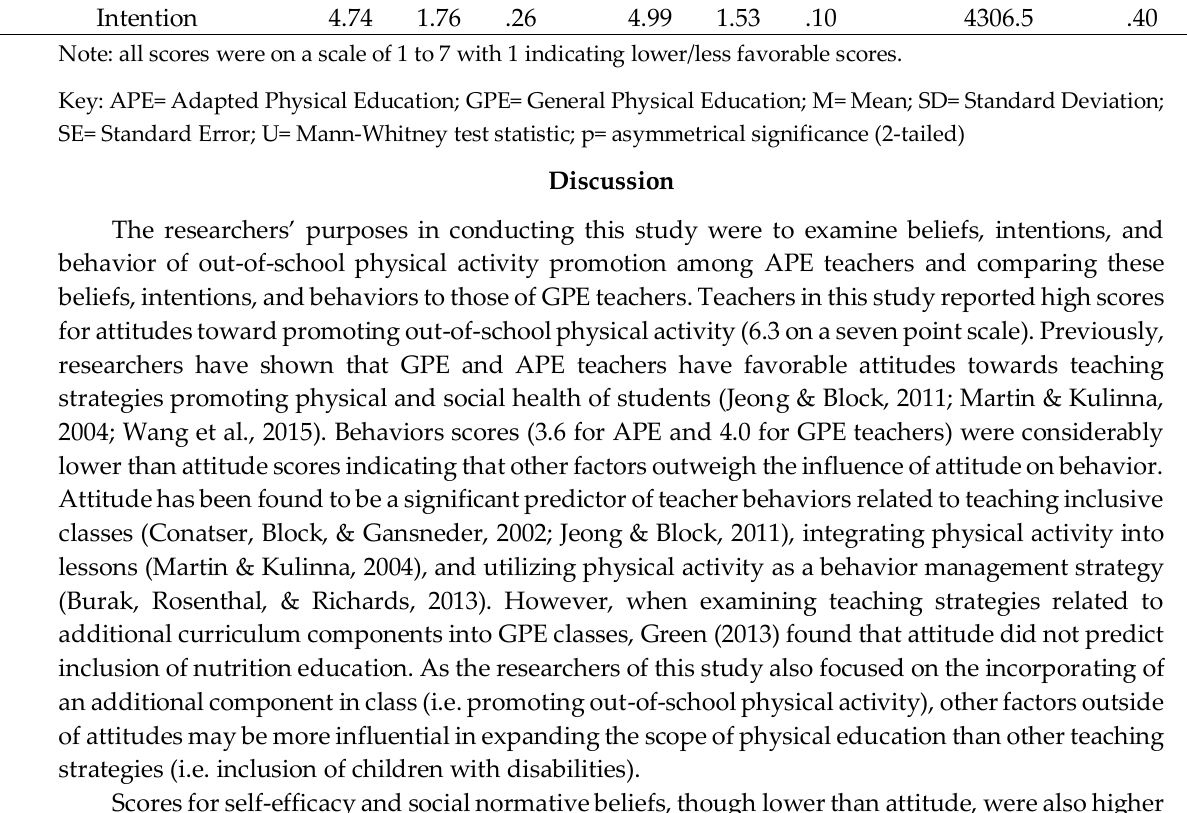
APE GPE Mann-Whitney Test